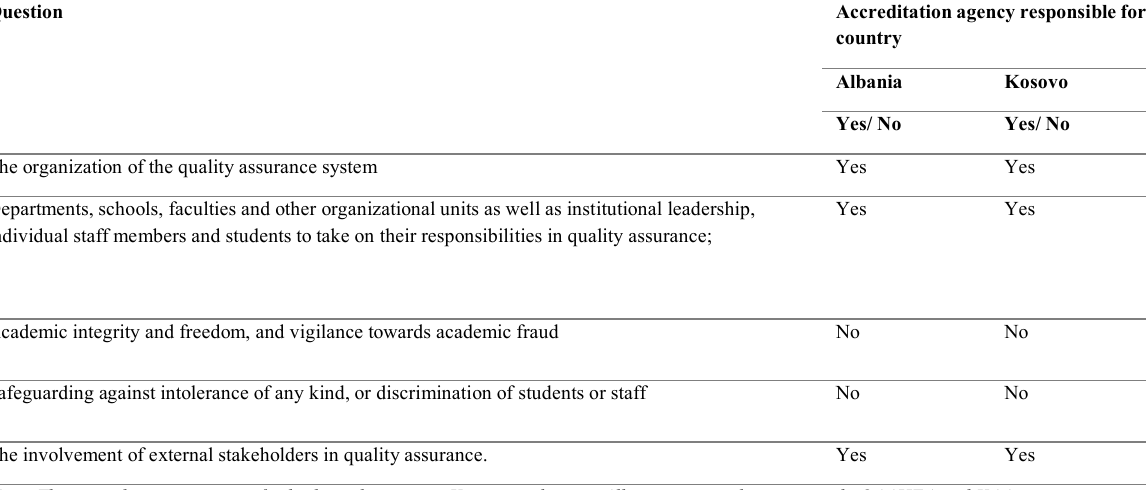
Table 11: Quality assurance policy requested form the accreditation agencies in Kosovo and Albania (QAAHEA and KAA) Question